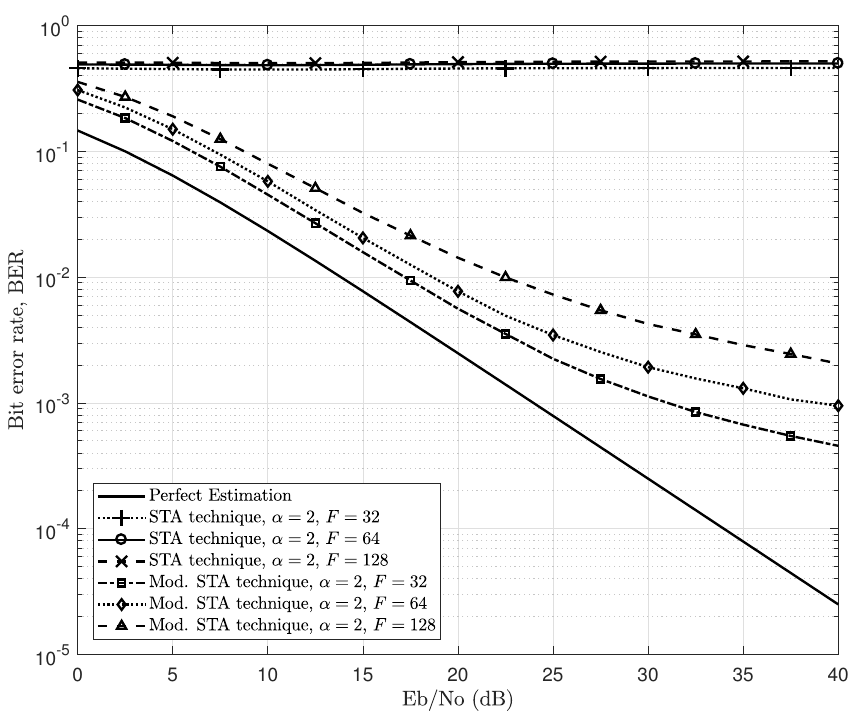
Figure 11. System performance by considering the modified STA technique with different frame lengths, initial speeds of ν T = ν R = 40 km/h, and acceleration components of a T = a R = 20 m/s 2 for Scenario